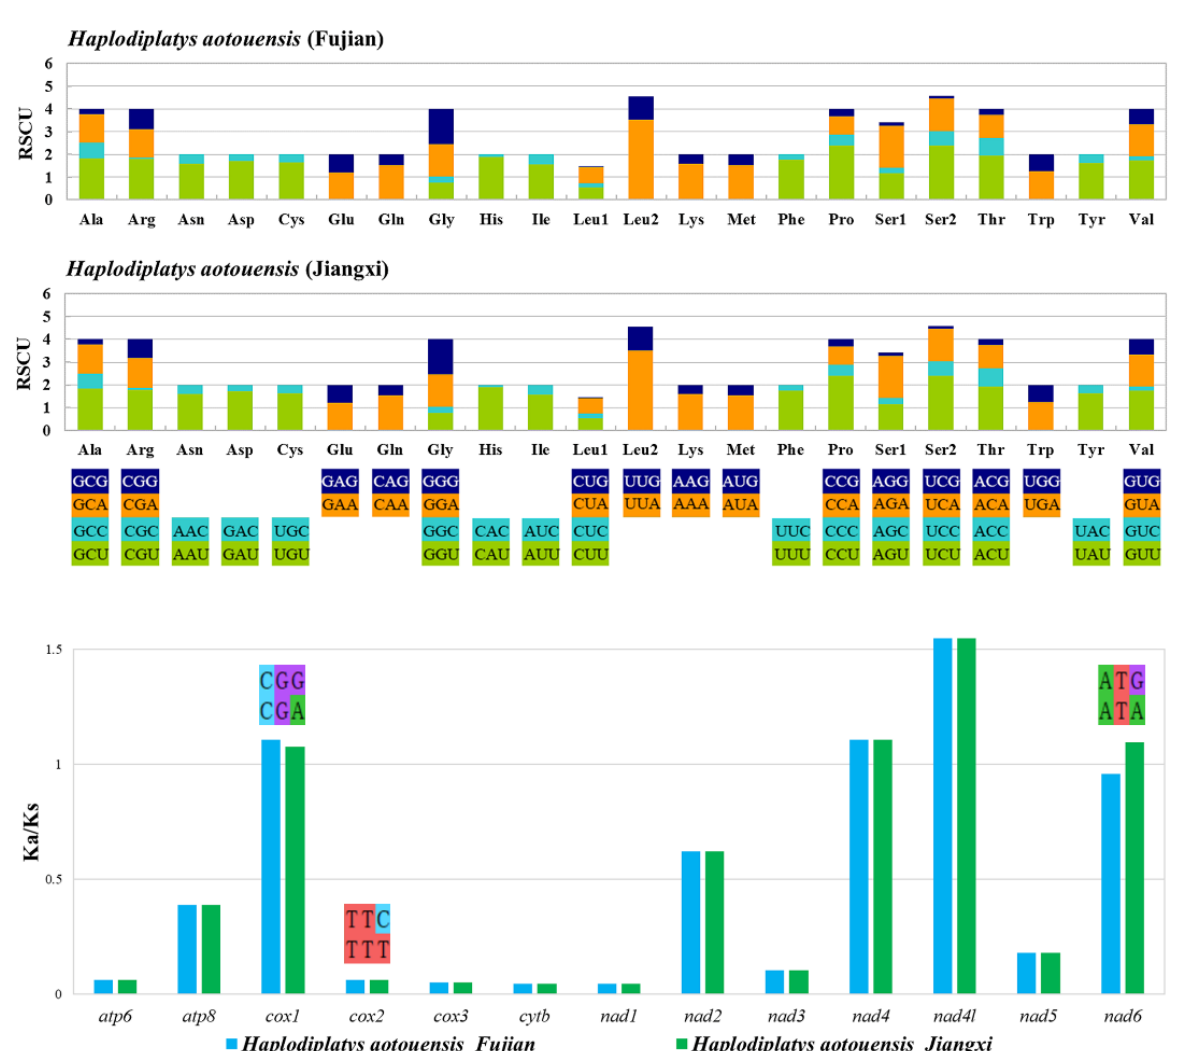
Figure 3. Relative synonymous codon usage (RSCU) and evolutionary rates of PCGs in Haplodiplatys aotouensis . In the Ka/Ks chart, t1he different codons between Fujian’s ( upper ) and Jiangxi’s ( lower ) samples are marked above the relevant PCGs.